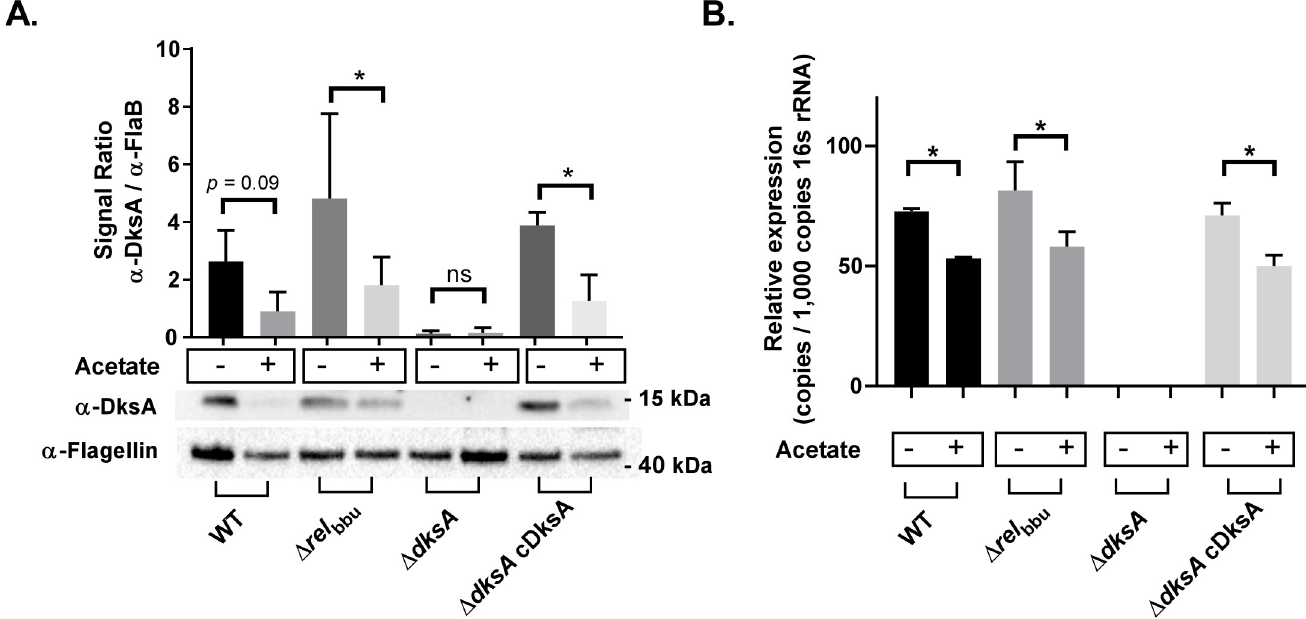
Fig 8. Detection of shifts in DksA protein and dksA RNA levels with change in growth media pH and organic acid level at mid-logarithmic growth. Whole cell lysates and RNA were collected from 297 wild-type (WT), Δ rel bbu , Δ dksA , and chromosomally complemented Δ dksA ( Δ dksA cDksA) B . burgdorferi strains cultured to 5 x 10 7 spirochetes / mL density in either BSKII-pH 7.6 (acetate -) or BSKII-pH 6.7 with 20 mM acetate (acetate +). Expression of DksA protein levels (A) were determined by densitometry of chemiluminescence signals and signals were normalized to expression of FlaB. RNA expression levels of dksA (B) were determined by RT-qPCR and were normalized to 16s rRNA expression levels. Data are representative of 3 replicate experiments. Asterisk indicate adjusted p -values < 0.05 a Sidak multiple comparisons test.